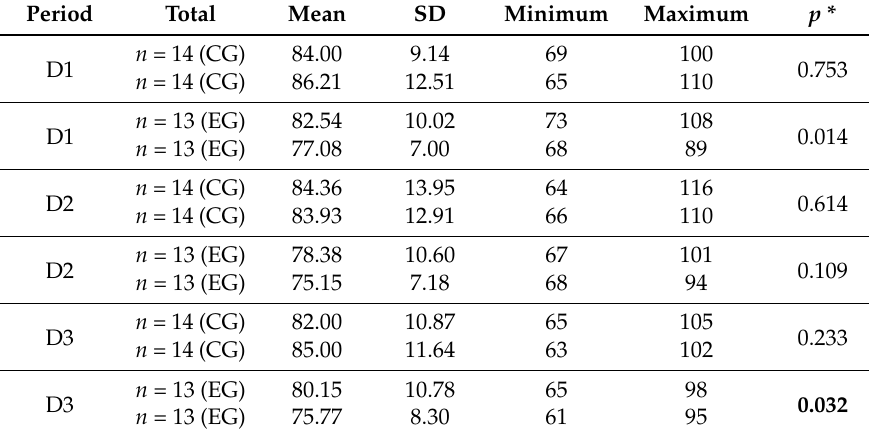
Table 5. Heart Rate before and after the intervention over the three